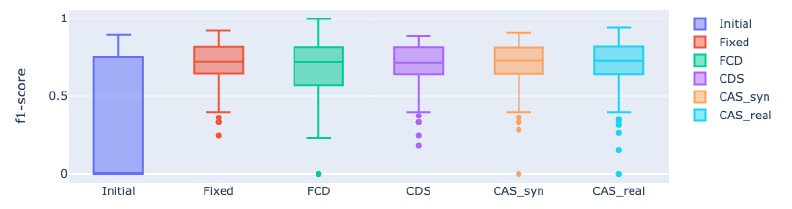
Figure 10. Box-plot of F1-scores of the minority class with different stopping methods for tor-based